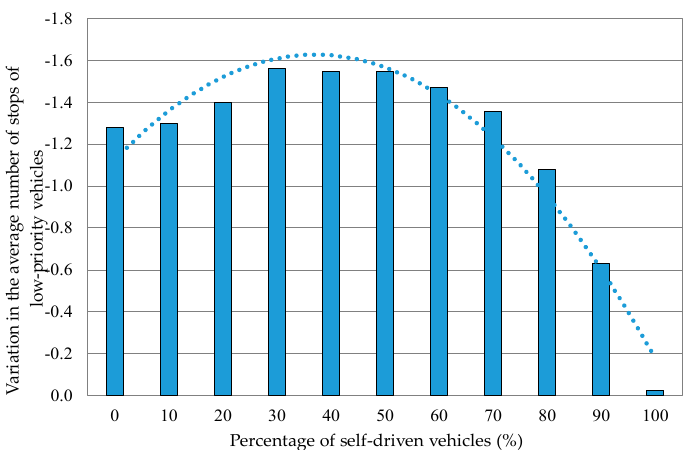
Figure 13. Variation in the average number of stops of low-priority vehicles when the percentage of self-driven vehicles was varied. The average number of stops was the average for all the vehicles that came in.